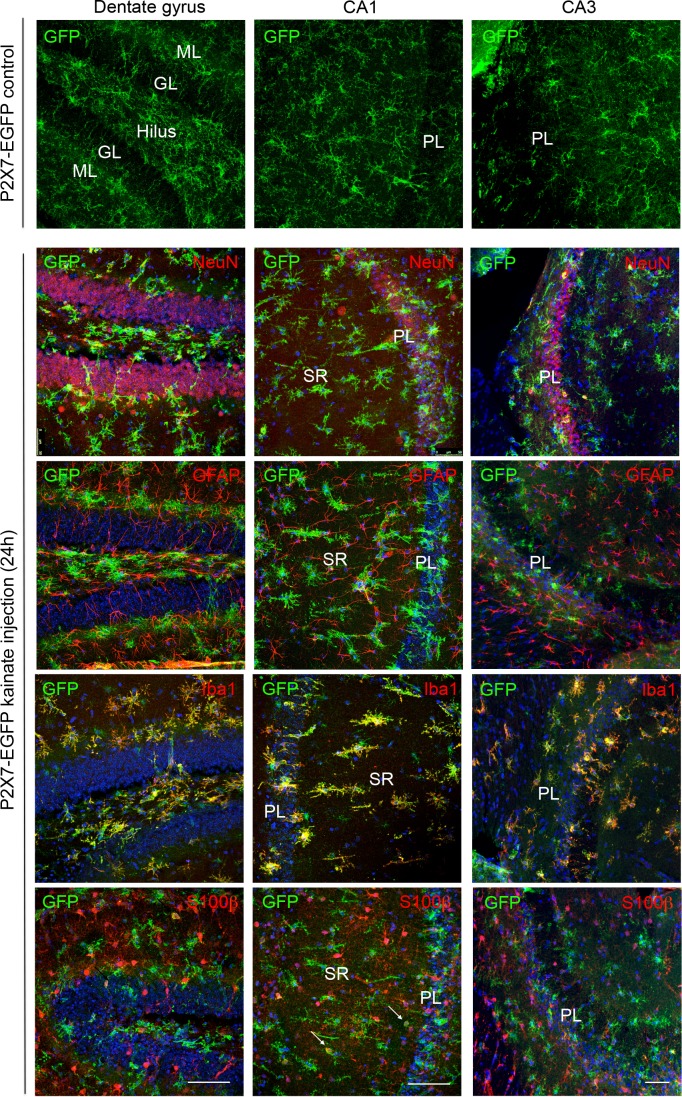
Cell type-specific P2X7-EGFP expression in the three hippocampal subfields (DG, CA1, and CA3) upon induction of status epilepticus.Upper panel EGFP (A10262, Thermo Fisher Scientific) staining of control-injected transgenic mice shows non-activated microglia. Lower panels Double labeling of P2X7-EGFP with neuronal marker NeuN, astrocyte marker GFAP (MAB360, Millipore), microglial marker Iba-1, and S100β (S2532, Sigma Aldrich) (in red) 24 hr after intraamygdala kainic acid-induced status epilepticus. Cell nuclei were counterstained with DAPI (blue). Scale bar: 50 μm.